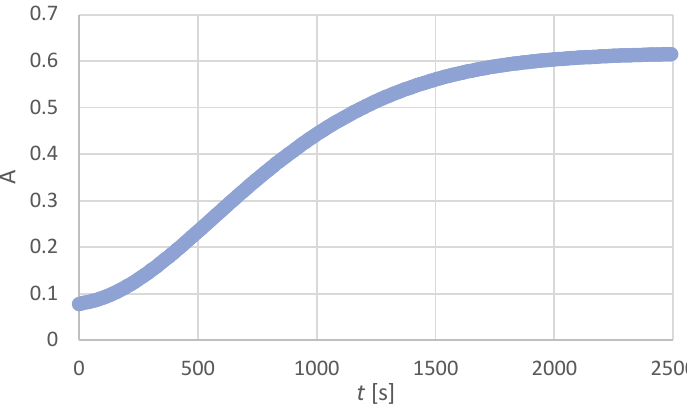
Table 3. The relative electronic (plain text) and Gibbs free (italics) energies (kcal/mol) of subsequent stages of the tandem Mannich — electrophilic amination reaction calculated by DFT/PCM methods.